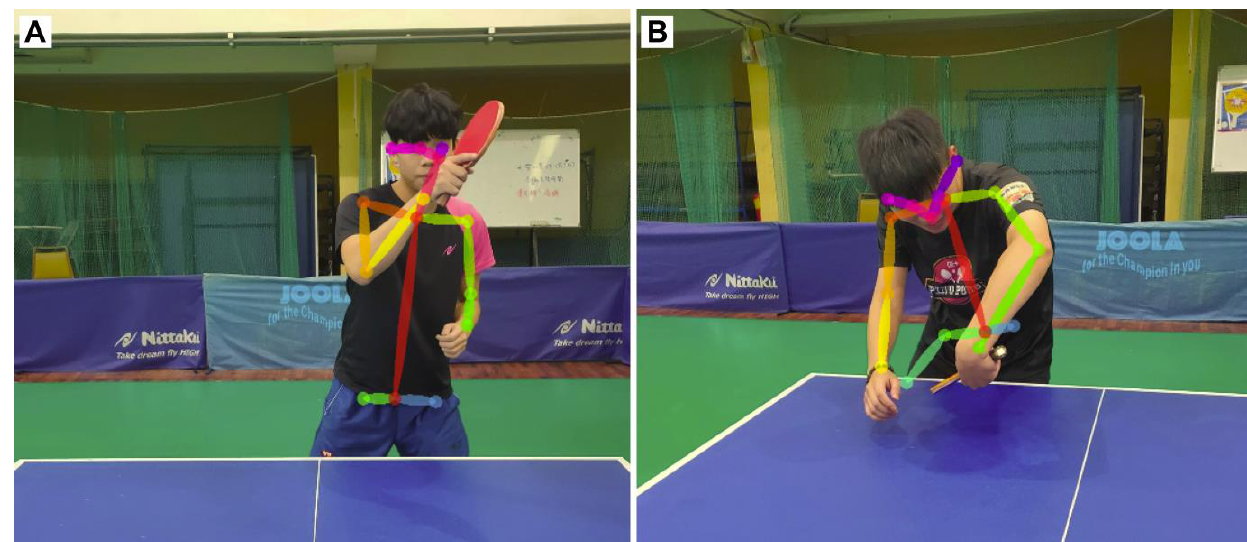
Figure 12. ( A ) Forehand loop (after analysis). ( B ) Backhand flick (after analysis). The forehand loop and backhand flick after analysis.